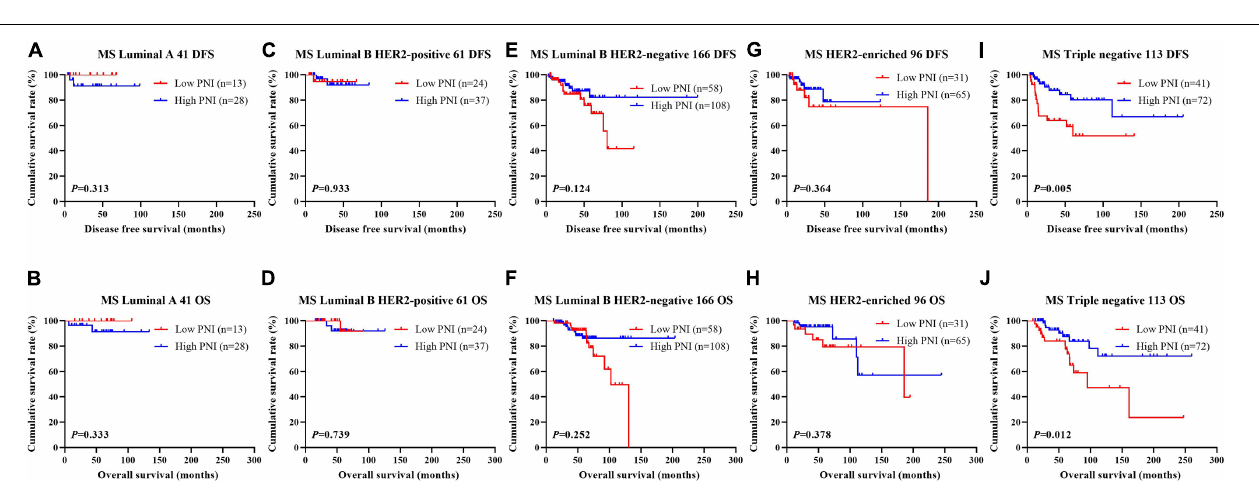
FIGURE 4 | Disease-free survival (DFS) and overall survival (OS) for the prognostic nutritional index (PNI) of patients with breast cancer in different molecular subtypes in the neoadjuvant chemotherapy (NACT) group. (A,B) Kaplan-Meier analysis of DFS (A) and OS (B) for the PNI of patients with luminal A breast cancer in NACT group. (C,D) Kaplan-Meier analysis of DFS (C) and OS (D) for the PNI of patients with luminal B HER2-positive breast cancer in NACT group. (E,F) Kaplan-Meier analysis of DFS (E) and OS (F) for the PNI of patients with luminal B HER2-negative breast cancer in NACT group. (G,H) Kaplan-Meier analysis of DFS (G) and OS (H) for the PNI of patients with HER2-enriched breast cancer in NACT group. (I,J) Kaplan-Meier analysis of DFS (I) and OS (J) for the PNI of patients with triple-negative breast cancer in NACT group.